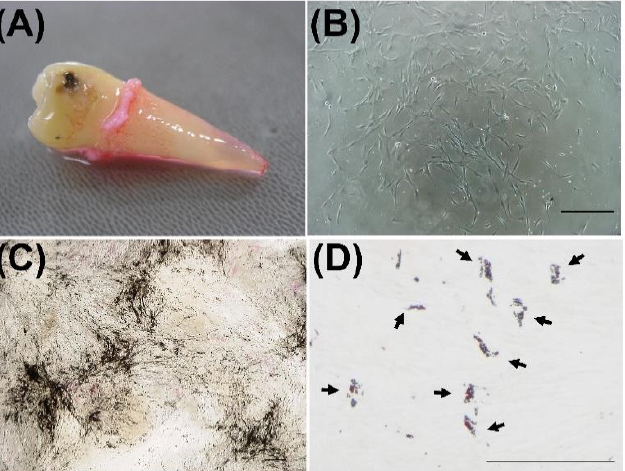
Figure 1. Isolation and characterization of periodontal ligament stem cells (PDLSCs). PDLSCs were isolated from the periodontal ligament (PDL) and characterized. PDL tissues were obtained from the extracted human tooth ( A ). Colony-forming fibroblastic cells were observed 9 days after enzymatic digestion of PDL ( B ). Images after von Kossa staining and Oil Red O staining of PDLSC culture are shown ( C , D ). Three weeks after the induction of osteoblastic differentiation, PDLSCs demonstrated von Kossa-positive calcium deposit formation. Four weeks after the induction of adipocyte differentiation, PDLSCs demonstrated Oil Red O-positive lipid accumulation in cytosolic space. Black arrows: Oil Red O-positive lipid droplets, Bar = 300 μm ( B ) and 100 μm ( C , D ).